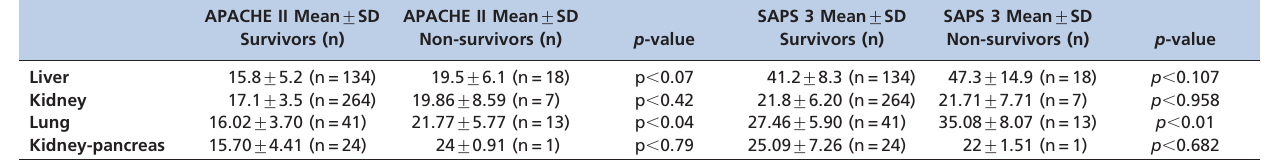
Table 1 - Survivors and non-survivors according to APACHE II and SAPS 3 scores: mean values ( ¡ SD) and hospital mortality obtained in the different transplant patient groups.